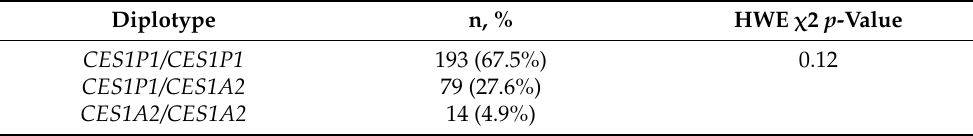
Table 1. Diplotype frequencies in the studied